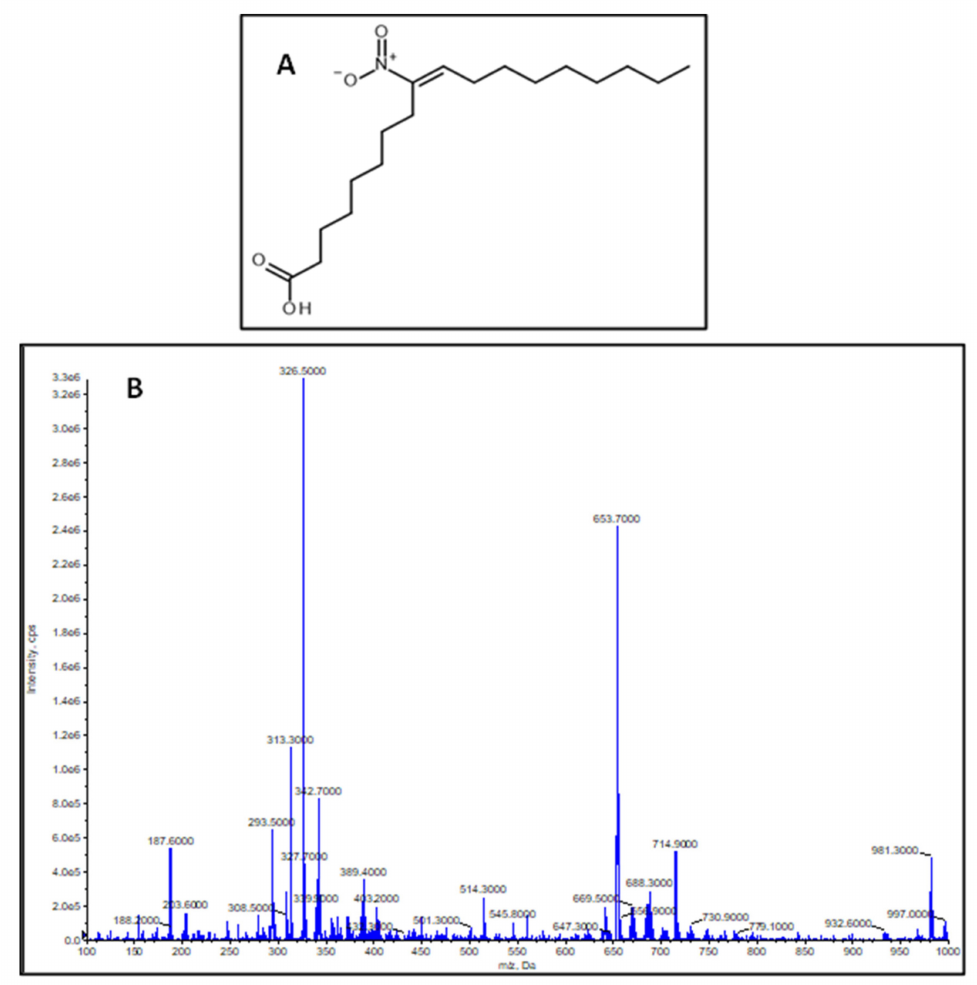
Figure 1. ( A ) Structure of ( E )-9-nitrooctadec-9-enoic acid. ( B ) Q1 MS scan of nitro-oleic acid (NO 2 -OA) standard. Scan range was set between m / z 100 and 1000 Da. Molecule ion peak [M − H] − was m / z